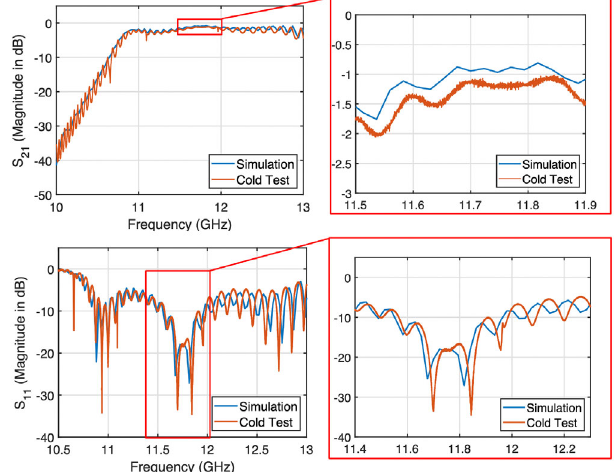
FIG. 11. S-parameters of the assembled structure were mea- sured with a VNA. S 21 (top) and S 11 (bottom) show excellent agreement with simulation.